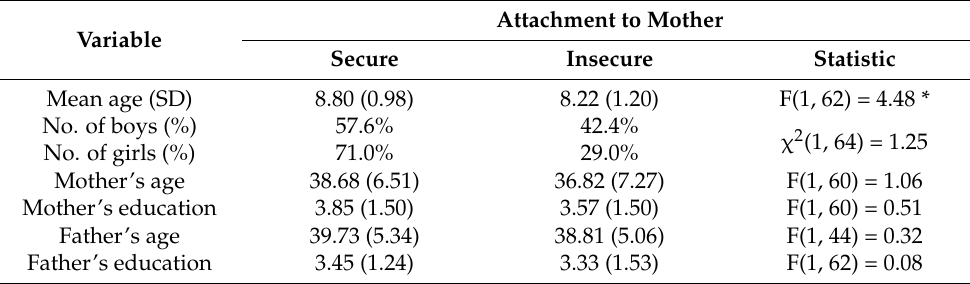
Table 1. Relations between children attachment security and parental demographic